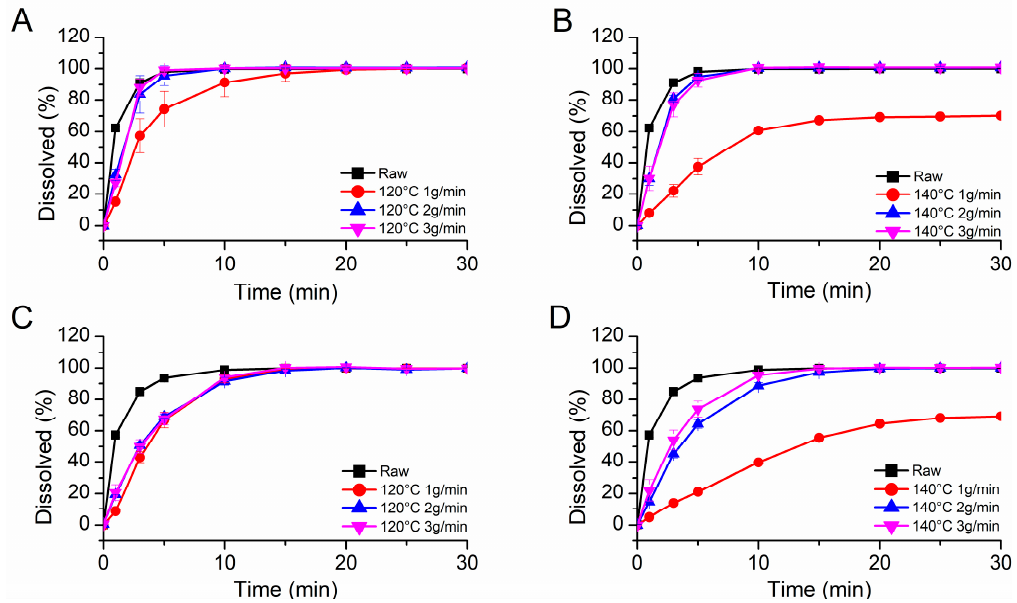
Figure 6. Dissolution times of the placebo extrudates at pH 6.8 ( A , B ) and at pH 5.5 ( C , D ). Table 2. Dissolution times of the placebo extrudates at pH 5.5 and pH 6.8, respectively.